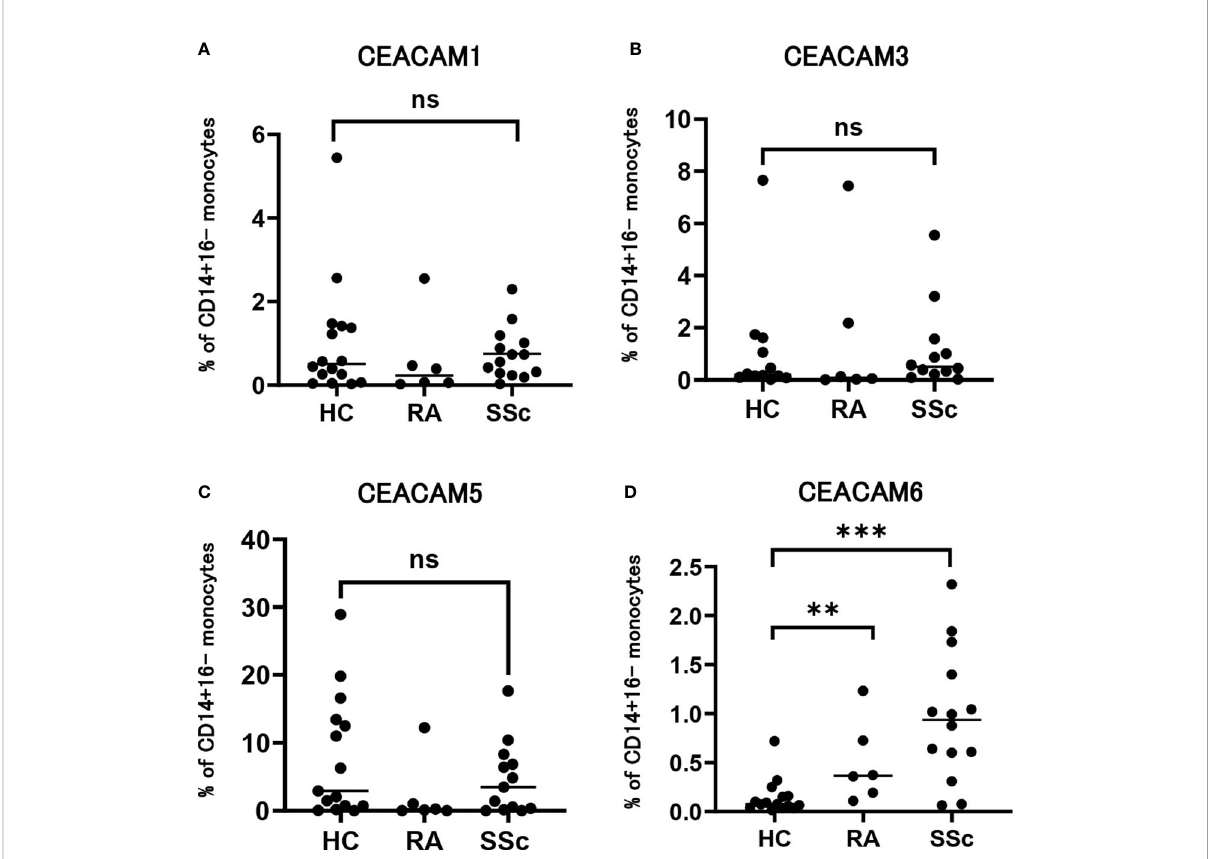
FIGURE 3 Expression of each subtype of CEACAM on SSc monocytes. (A-D) Dot plots show the proportion of positivity of CEACAM1 (A) , CEACAM3 (B) , CEACAM5 (C) , and CEACAM6 (D) on CD14+CD16- classical monocytes from HCs and patients with RA and SSc. P values were calculated